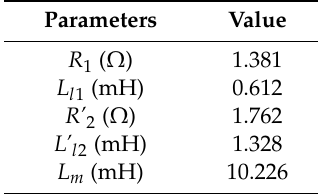
Table 5. Parameters of pump-type motor. Parameters